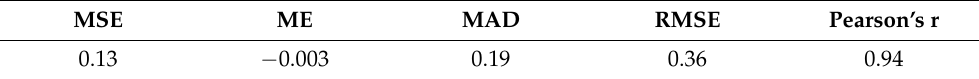
Table 4. Evaluation metrics of HbA1c for the transmission-type fingertip model.